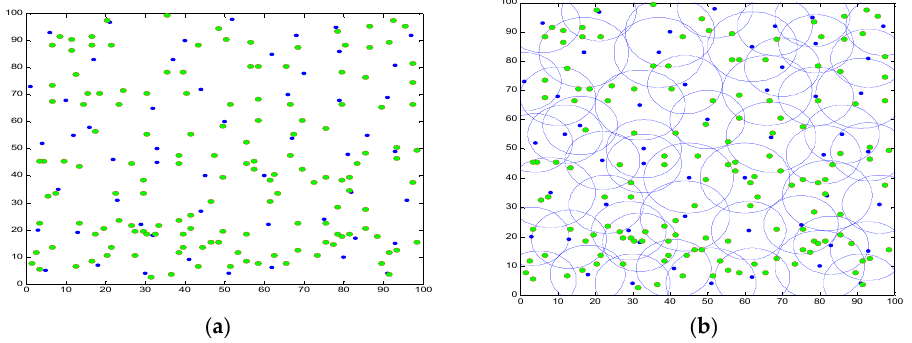
Figure 7. The distribution and coverage of active nodes after sleep scheduling. ( a ) Dormant nodes’ deployment; ( b ) Coverage area.